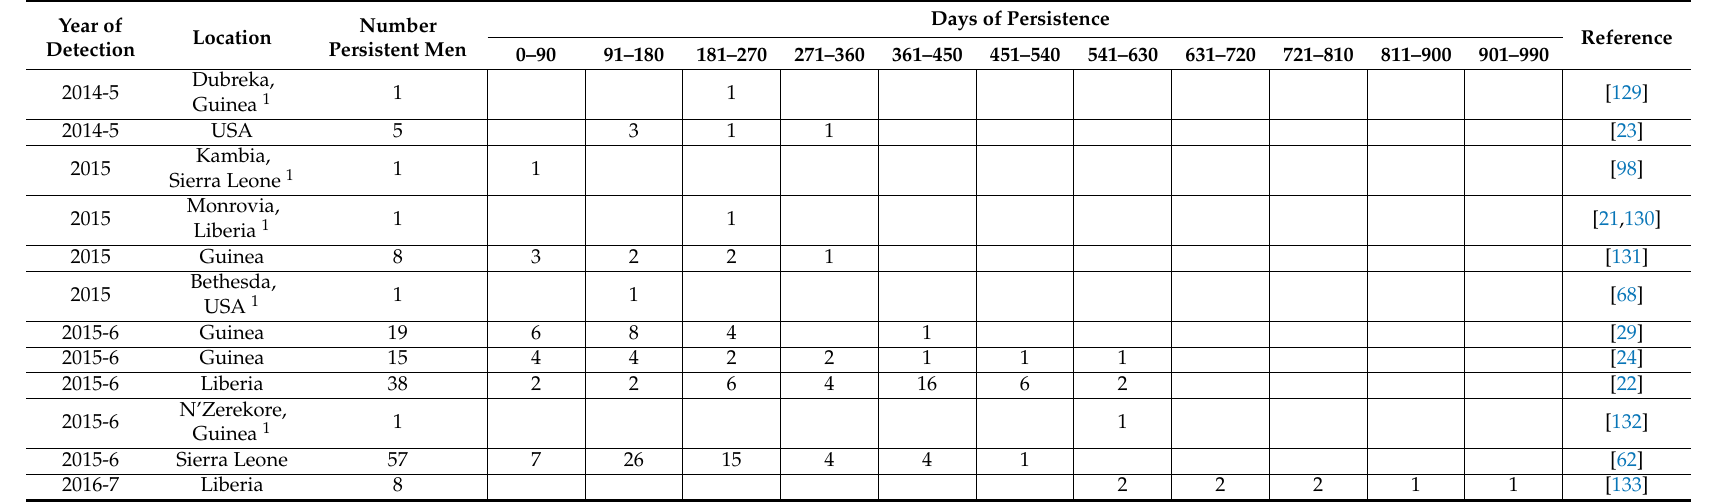
Table 2. Compilation of male persistence cases reported during the West African EVD